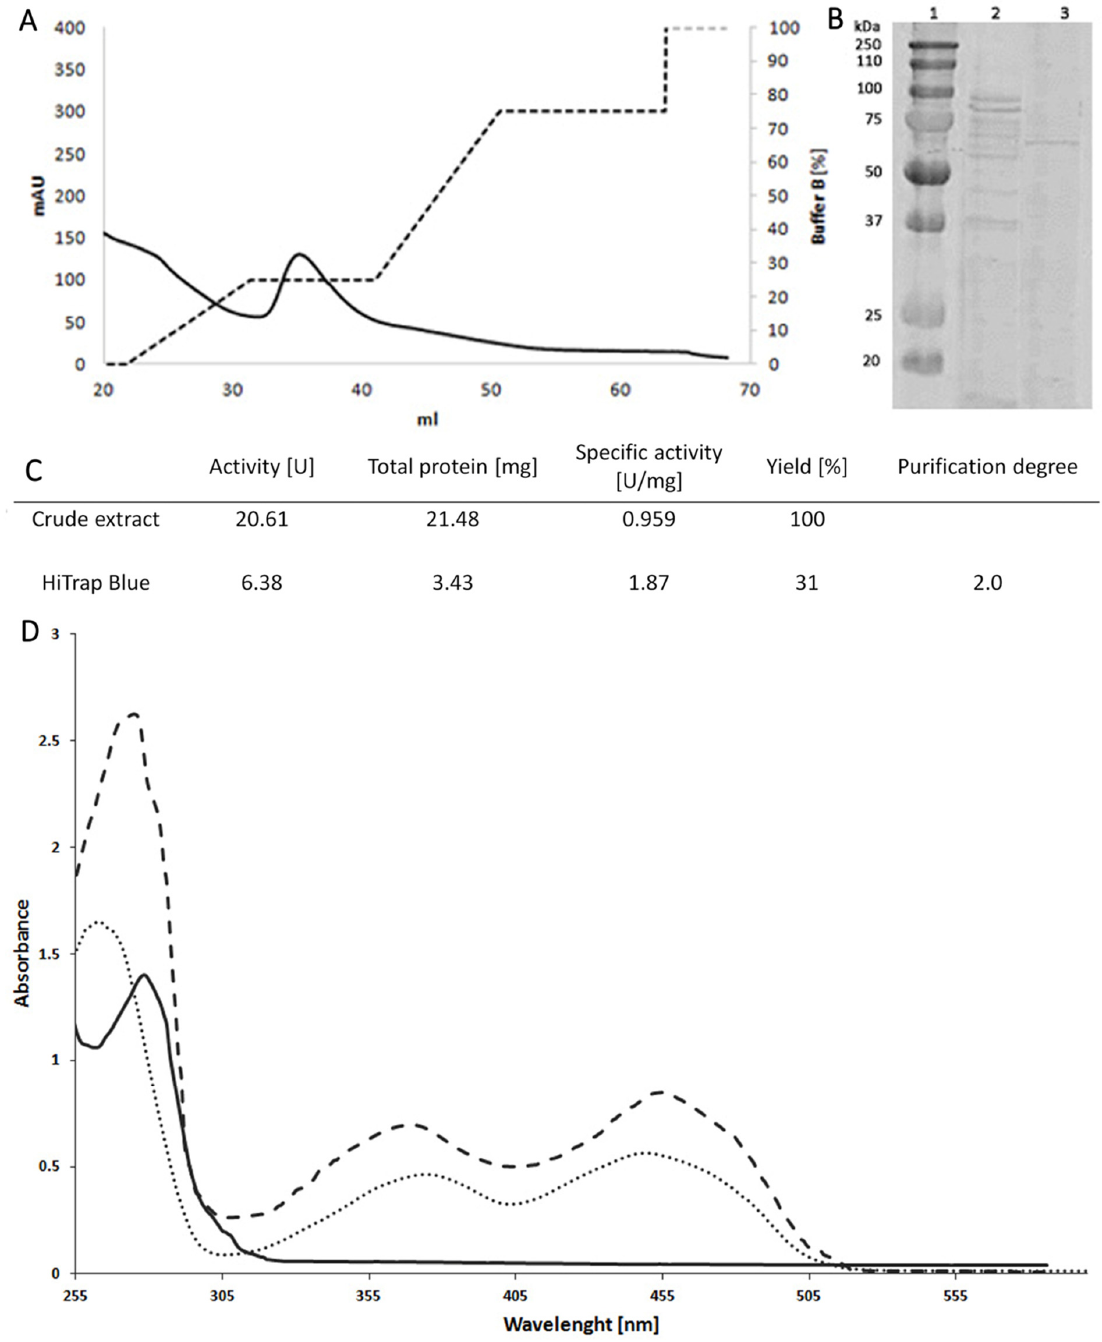
Figure 4. Purification of psychrophilic MAO P3. ( A ) Elution profile of apoenzyme MAO P3 from HiTrap Blue (black line), with a step gradient of buffer B (dashed line). MAO P3 was eluted from the column at 20% of the buffer B gradient which represents a 0.4 M concentration of KCl. ( B ) SDS-PAGE electropherogram of MAO P3 after purification: lane 1, molecular mass standard (Precision Plus protein standard); lane 2, intracellular protein extract; lane 3, active fraction from HiTrap Blue column. ( C ) Summary of puri- fication of the apoenzyme on HiTrap Blue column. ( D ) UV-visible absorbance spectrum of apoMAO P3 (full line), reconstituted MAO P3 (dashed line), and free FAD (dotted line). All the spectra were measured in 0.01 M potassium phosphate buffer pH 7.2. For apoprotein, there is only maximum absorbance at 280 nm. After 20 min of incubation with 25 μ M of FAD, we can observe the re- constitution of active MAO.